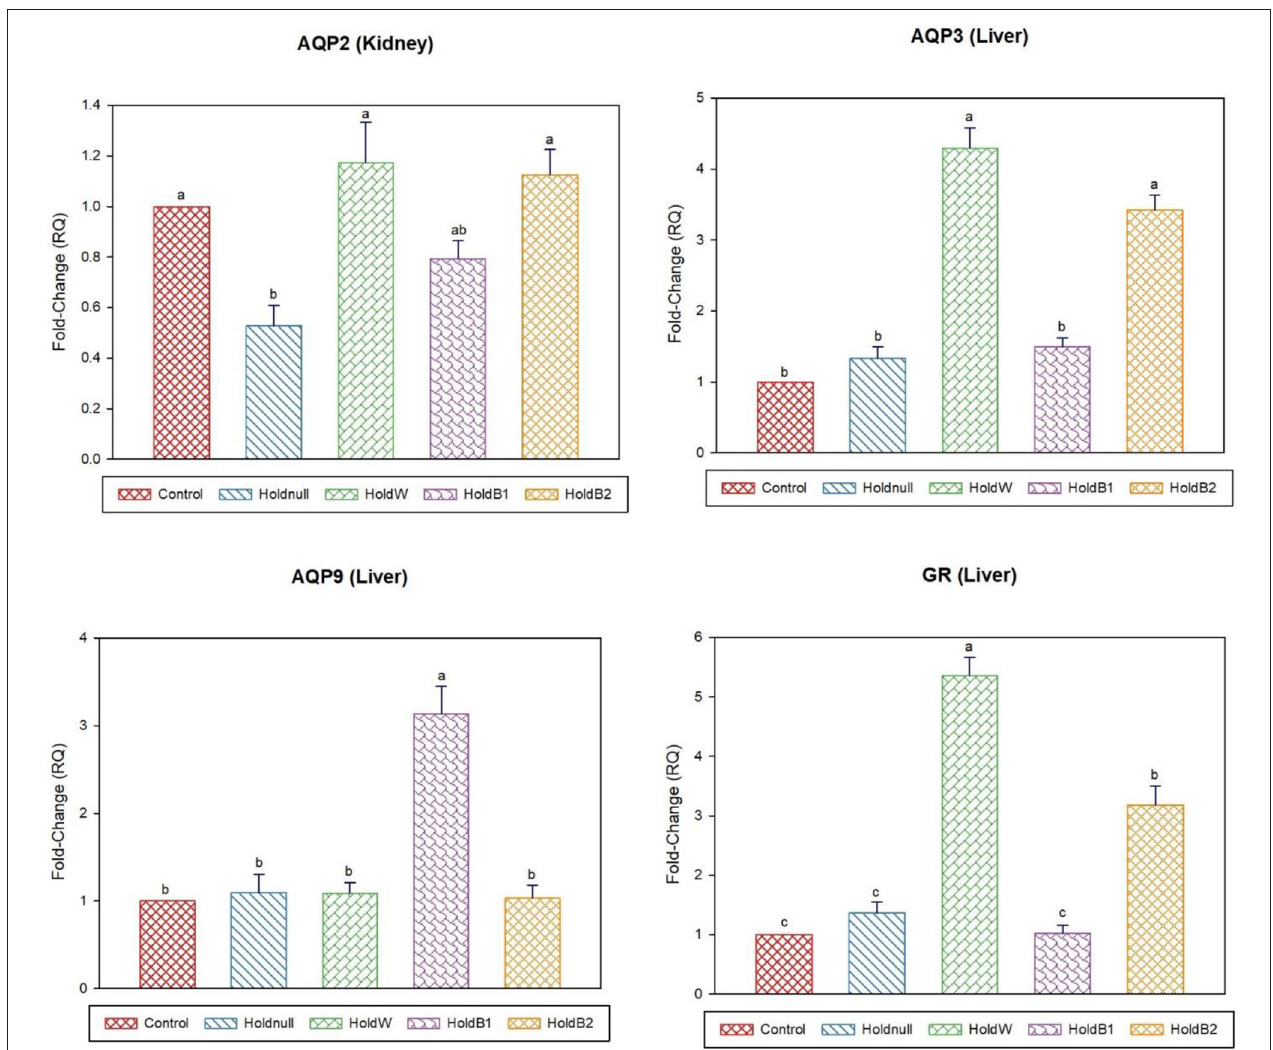
FIGURE 4 | Effect of betaine on the relative expression (fold-change or RQ) of AQP3, AQP9, GR in the liver, and AQP2 in the kidney of day-5 old chicks. Control, placed on feed immediately; Holdnull, holding for 48h + no access to feed or water; HoldW, holding for 48h + water only; HoldB1, holding for 48h + water supplemented with betaine (1ml per L); HoldB2, holding for 48h + water supplemented with betaine (2ml per L). Bars with different letters are significantly different ( p < 0.05). Mean ± standard error of the mean, n = 6. AQP, aquaporin; GR, glucocorticoids